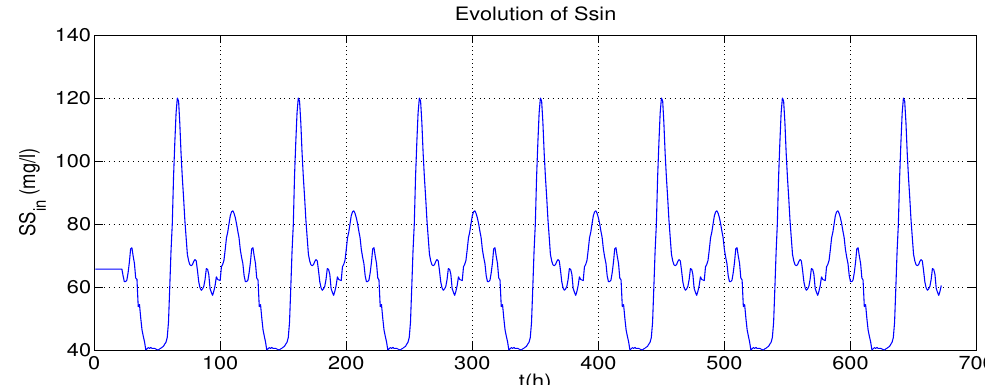
Figure 4. Concentration of organic matter in the influent S s